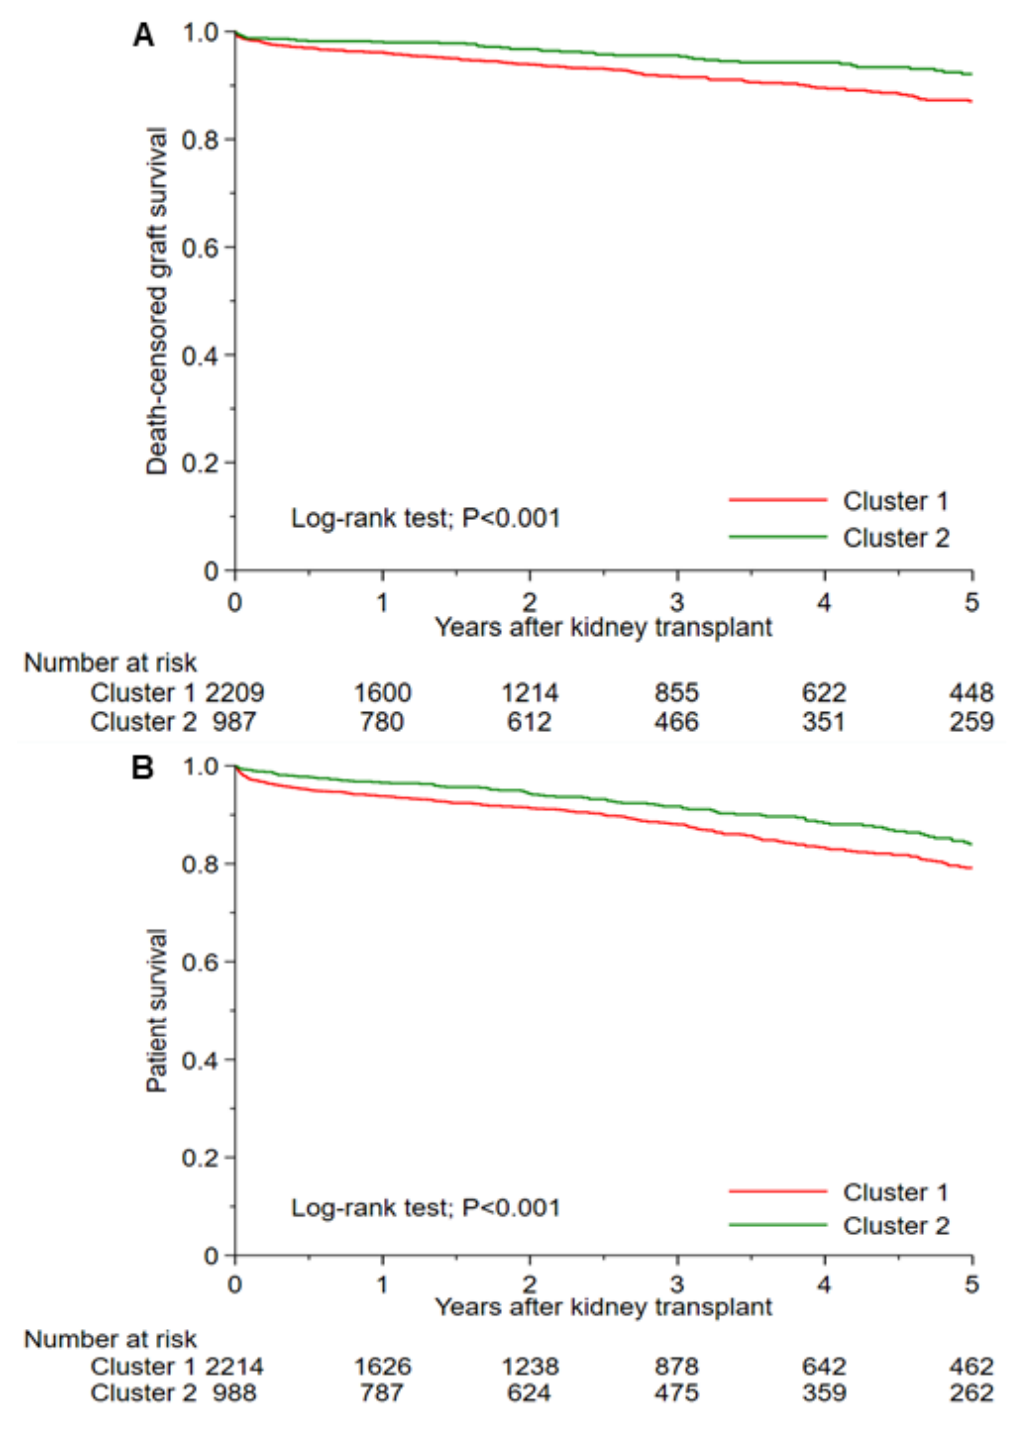
Figure 4. ( A ) Death-censored graft failure and ( B ) patient survival after kidney transplant among two unique clusters of functionally disabled kidney transplant recipients.